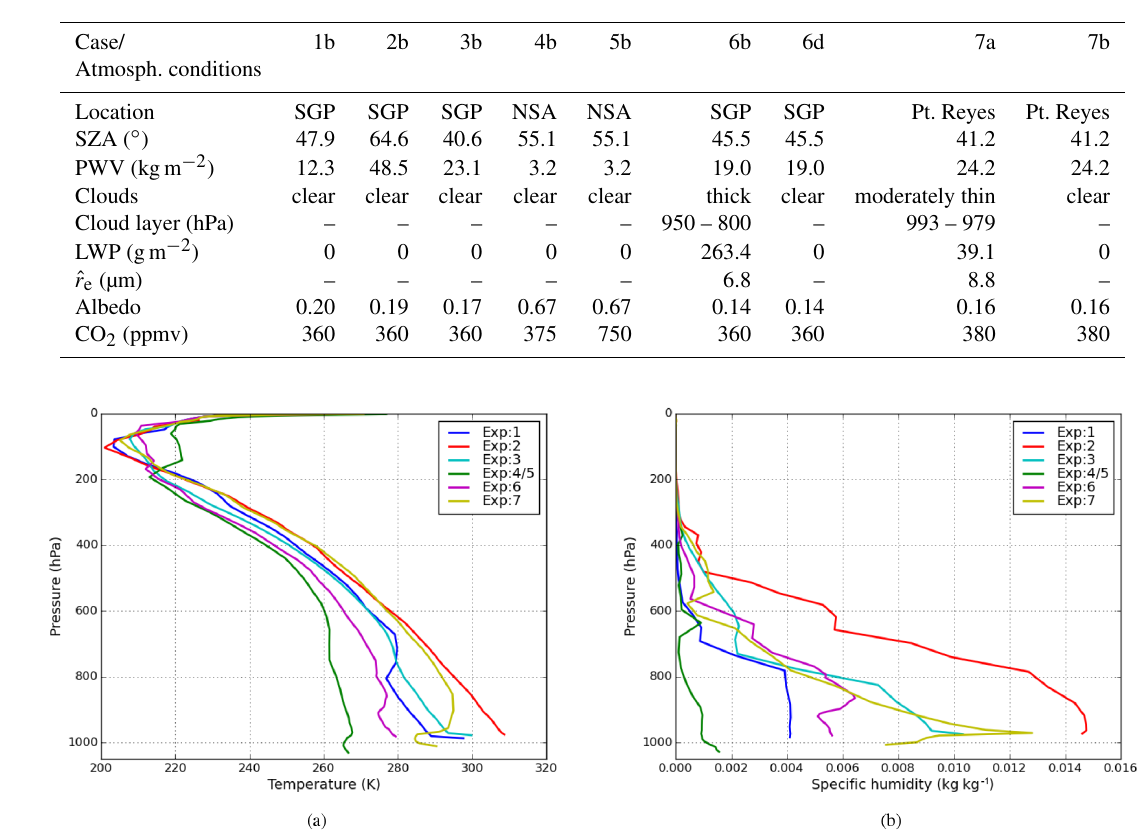
clouds. The biases in LWDS for NBM relative to LBL are small and positive for all cases ( < 9 W m − 2